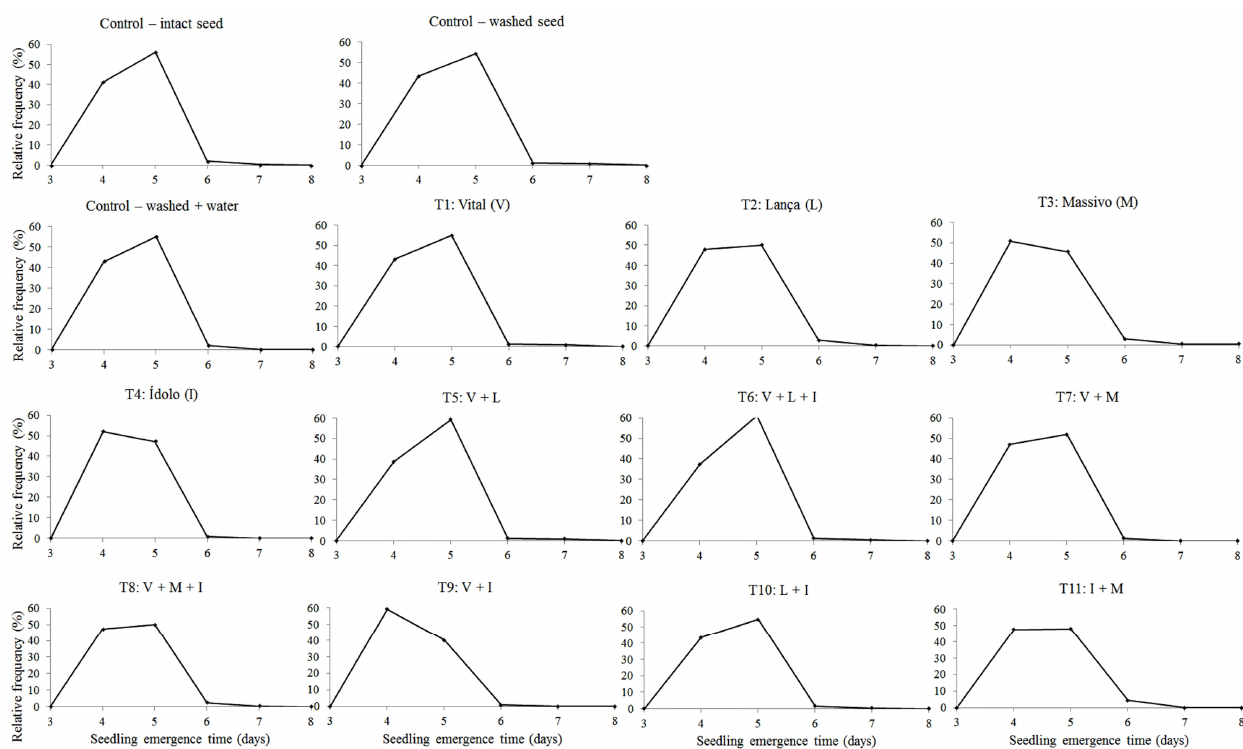
Figure 3. Distribution of relative frequency of corn MG744 PWU seedling emergence in the field from different seed treatments. Jataí, GO, Brazil, 2022.